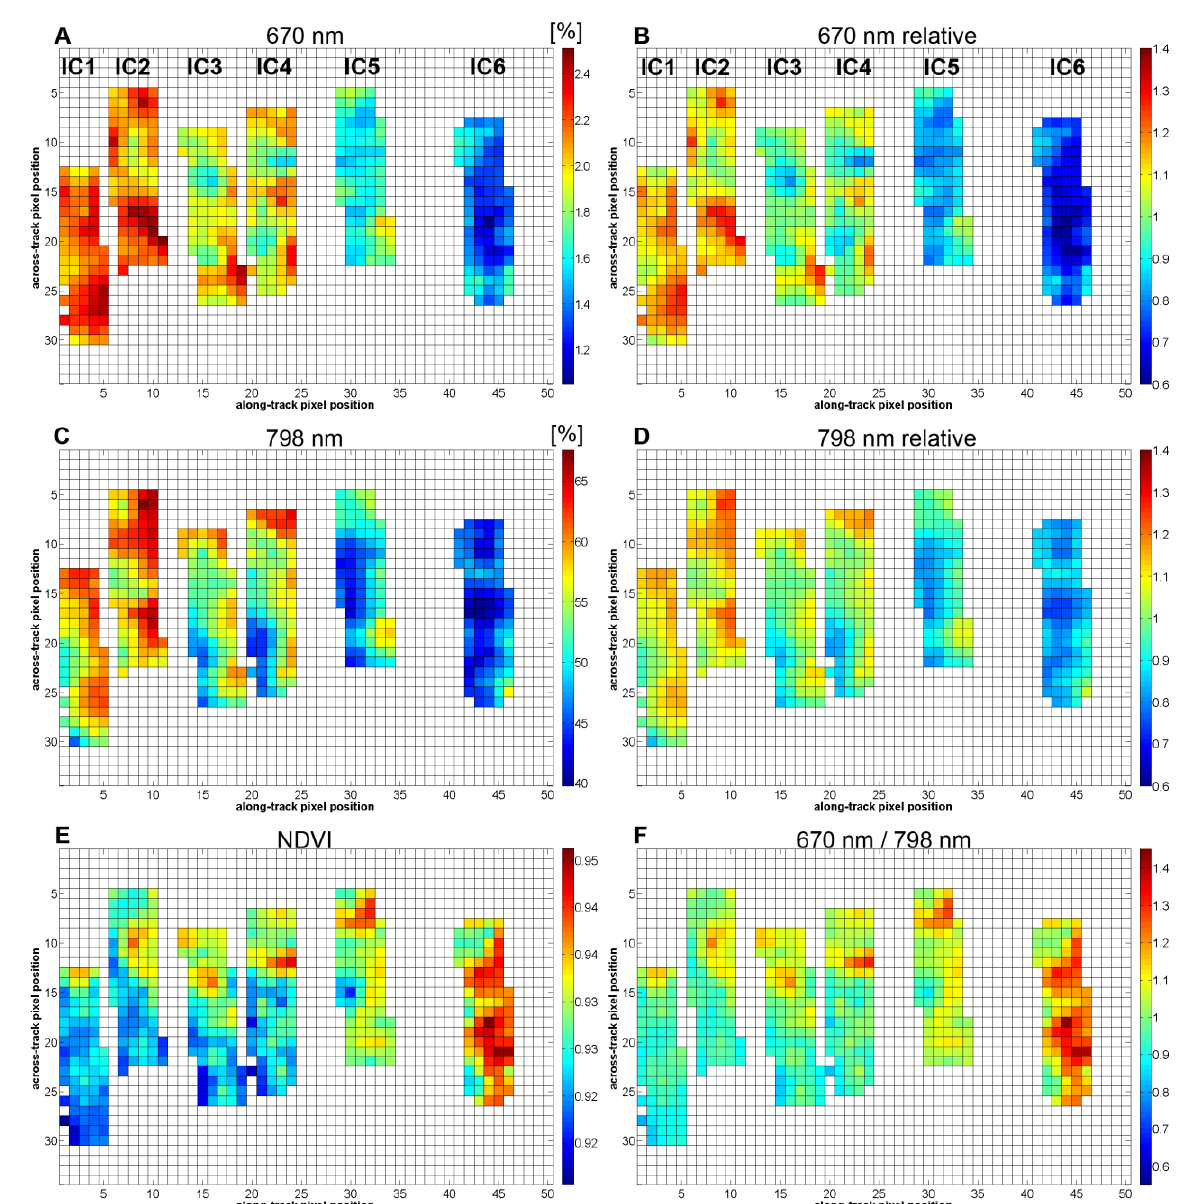
Figure 2 Visualization of the spectral information for the available pixel position within the pixel database for image cube (IC) 1 to 6 at 670 nm and 798 nm as absolute reflectance values (A,C) and relative values (B,D). Additionally, the NDVI (E) and the ratio of the relative reflectance at 670 nm and 798 nm (F) is